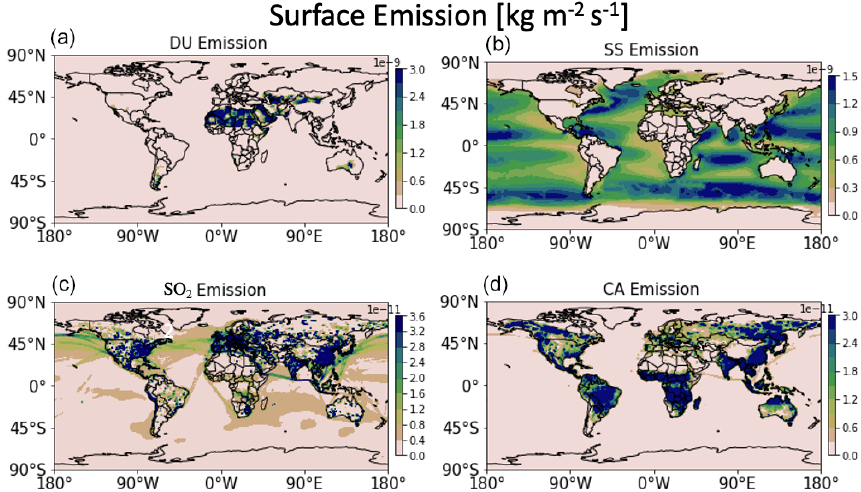
Figure 2. Annual surface emission (kgm − 2 s − 1 ) of (a) DU, (b) SS, (c) SO 2 , and (d) CA (BC plus OC) aerosol species during 1997–2014 from MERRA-2